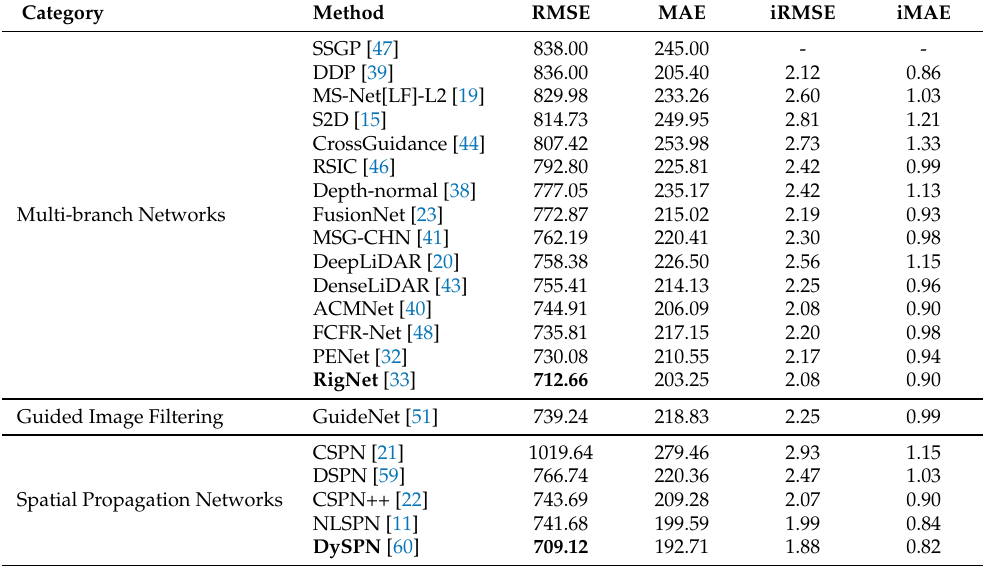
Table 2. Comparison of State-of-the-art approaches on the KITTI Benchmark test dataset. The methods are ordered by their RMSE results from worst to best within each category. The best results within each category are mentioned in bold letters.